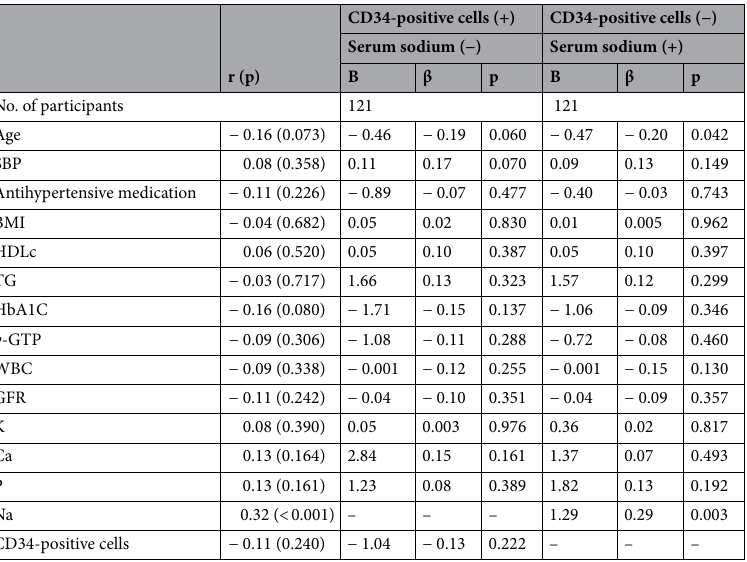
Table 2. Results of simple correlation analysis and multiple linear regression analysis for subjects without hypertension of handgrips strength with relevant factors adjusted for confounding factors. SBP systolic blood pressure, BMI body mass index, HDLc HDL-cholesterol, TG triglycerides, γ-GTP γ-glutamyltranspeptidase, GFR glomerular filtration rate, r (p) simple correlation coefficient (p value), Β parameter estimate, β standardized parameter estimate, p p value for multivariable linear regression models, Triglycerides γ-GTP, and CD34-positive cell levels were are calculated as logarithm values.